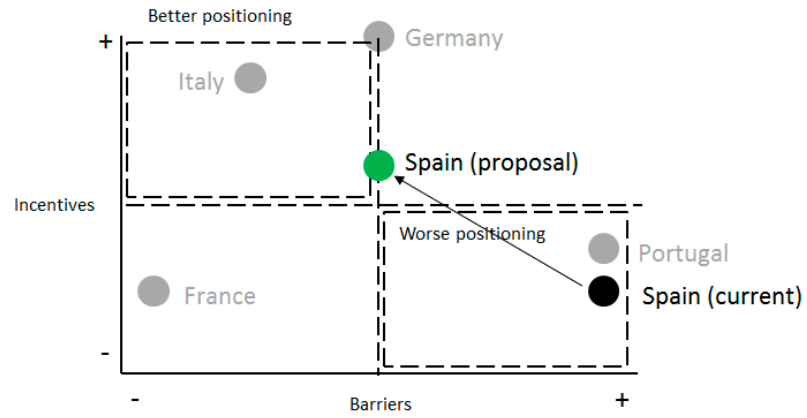
Figure 8. Favorable positioning for the development of self-consumption systems (own elaboration).